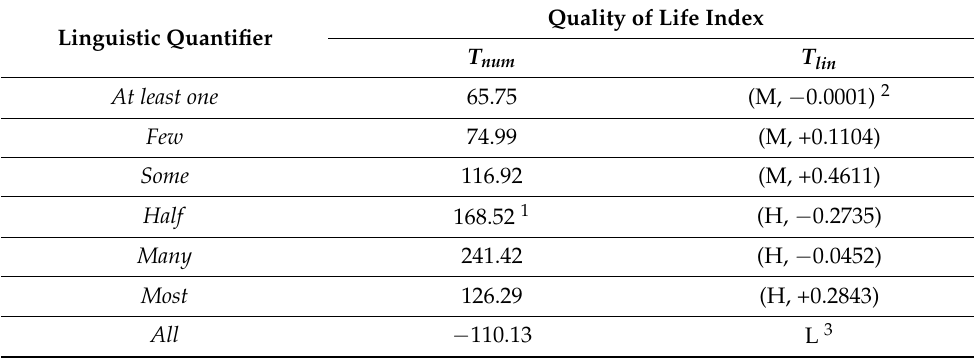
Table 6. Spain’s quality of life index calculation using linguistic